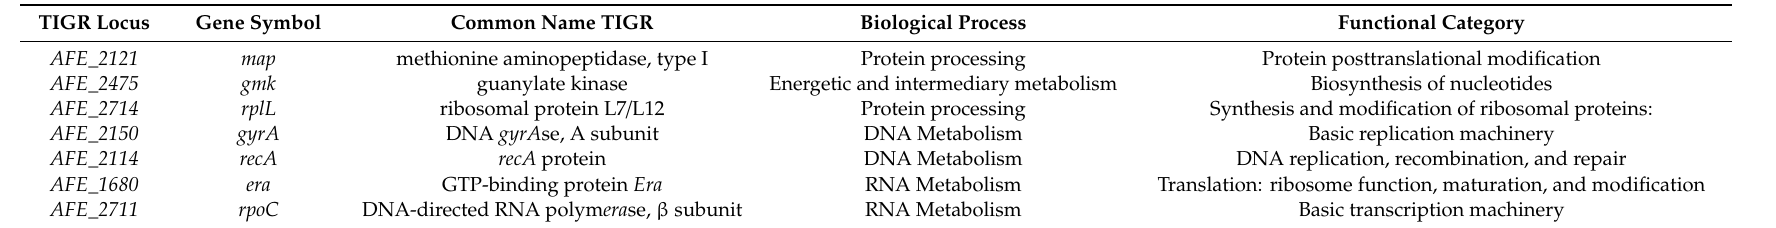
Table 2. The characteristics of seven candidate reference genes from At. ferrooxidans